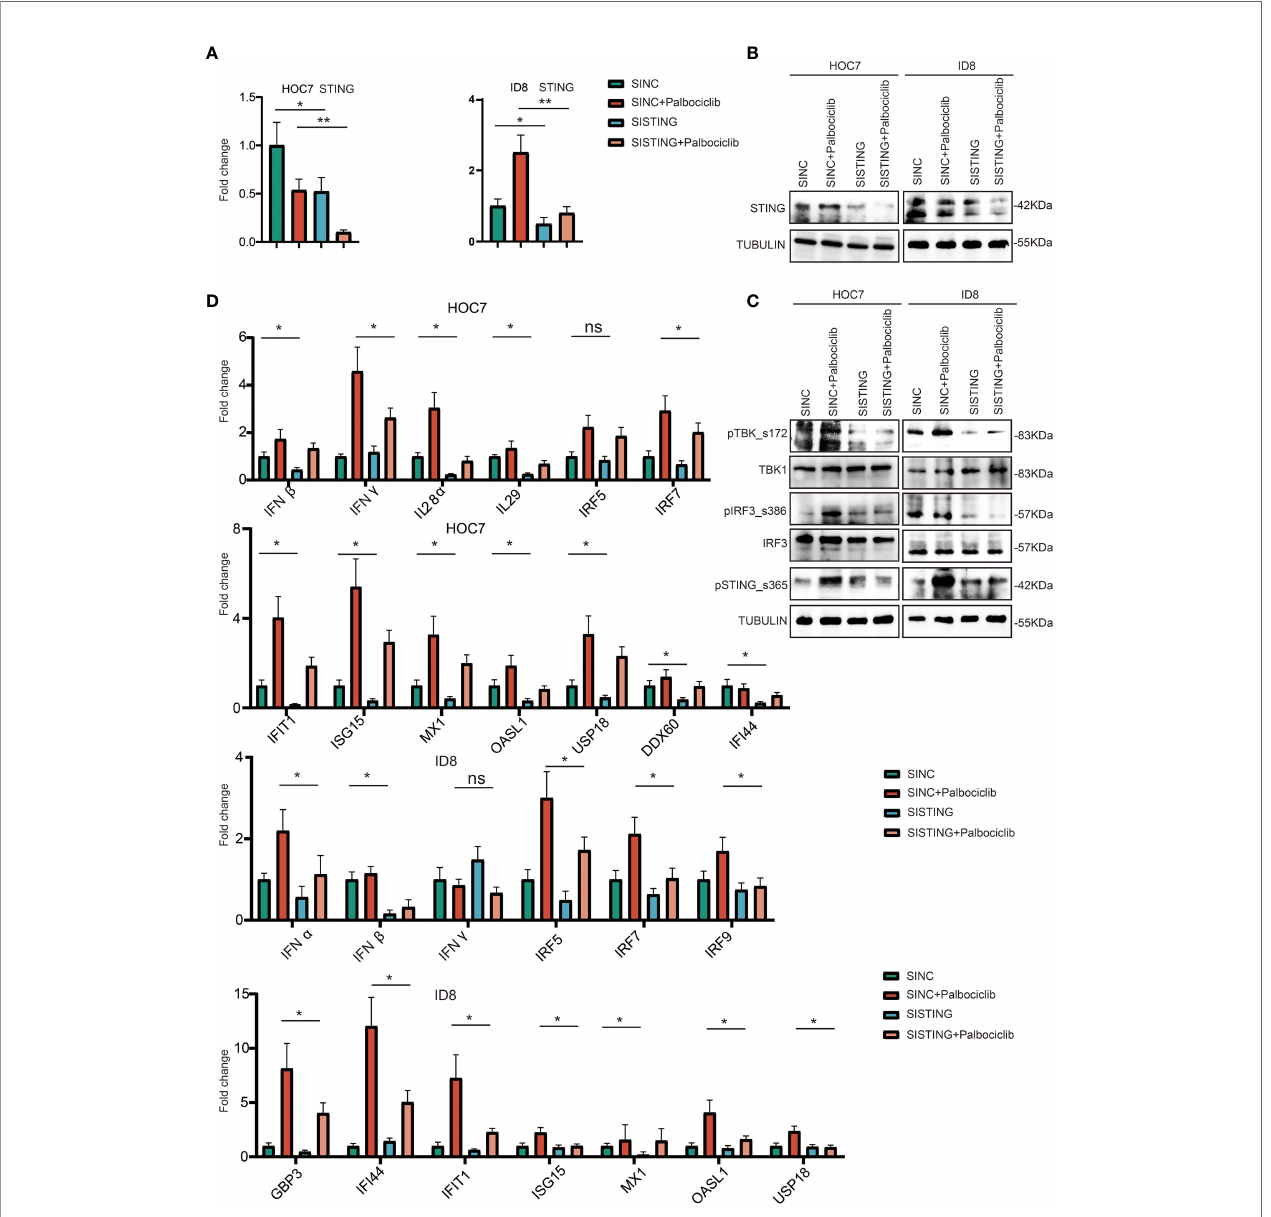
FIGURE 7 | CDK4/6 inhibitor palbociclib is at least partly dependent on STING to activate immunity in OC. (A) QRT-PCR analysis of STING expression level in ID8 and HOC7 treated with siNC, siNC + Palbociclib, siSTING, and siSTING + Palbociclib for 72 h. The p values were calculated using the Student t-test: ns as nonsense, *P < 0.05, **P < 0.01, (B) Western immunoblotting demonstrating expression of STING in ID8 and HOC7 treated with siNC, siNC + Palbociclib, siSTING, and siSTING + Palbociclib for 72 h. Tubulin was used as a loading control. (C) Western immunoblotting demonstrating expression of STING pathway in ID8 and HOC7 treated with siNC, siNC + Palbociclib, siSTING, and siSTING + Palbociclib for 72 h. Tubulin was used as a loading control. (D) QRT-PCR analysis of ISG, IFN, antigen presentation related pathway in ID8 and HOC7 treated with siNC, siNC + Palbociclib, siSTING, and siSTING + Palbociclib for 72 h. The p values were calculated using the Student t-test: ns as nonsense, *P < 0.05, **P <